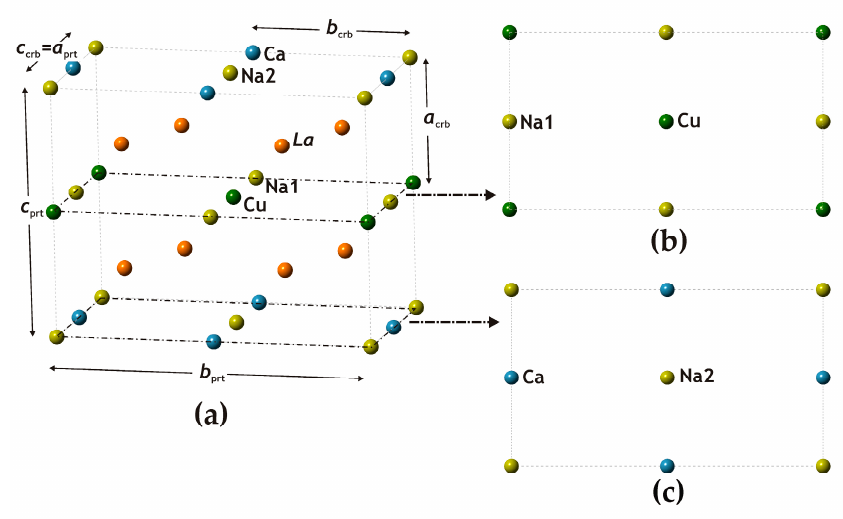
Figure 4. The cation arrangement in the unit cell of the crystal structure of paratooite-(La) ( a ) and its sections on the levels z = ½ ( b ) and 0 ( c ).